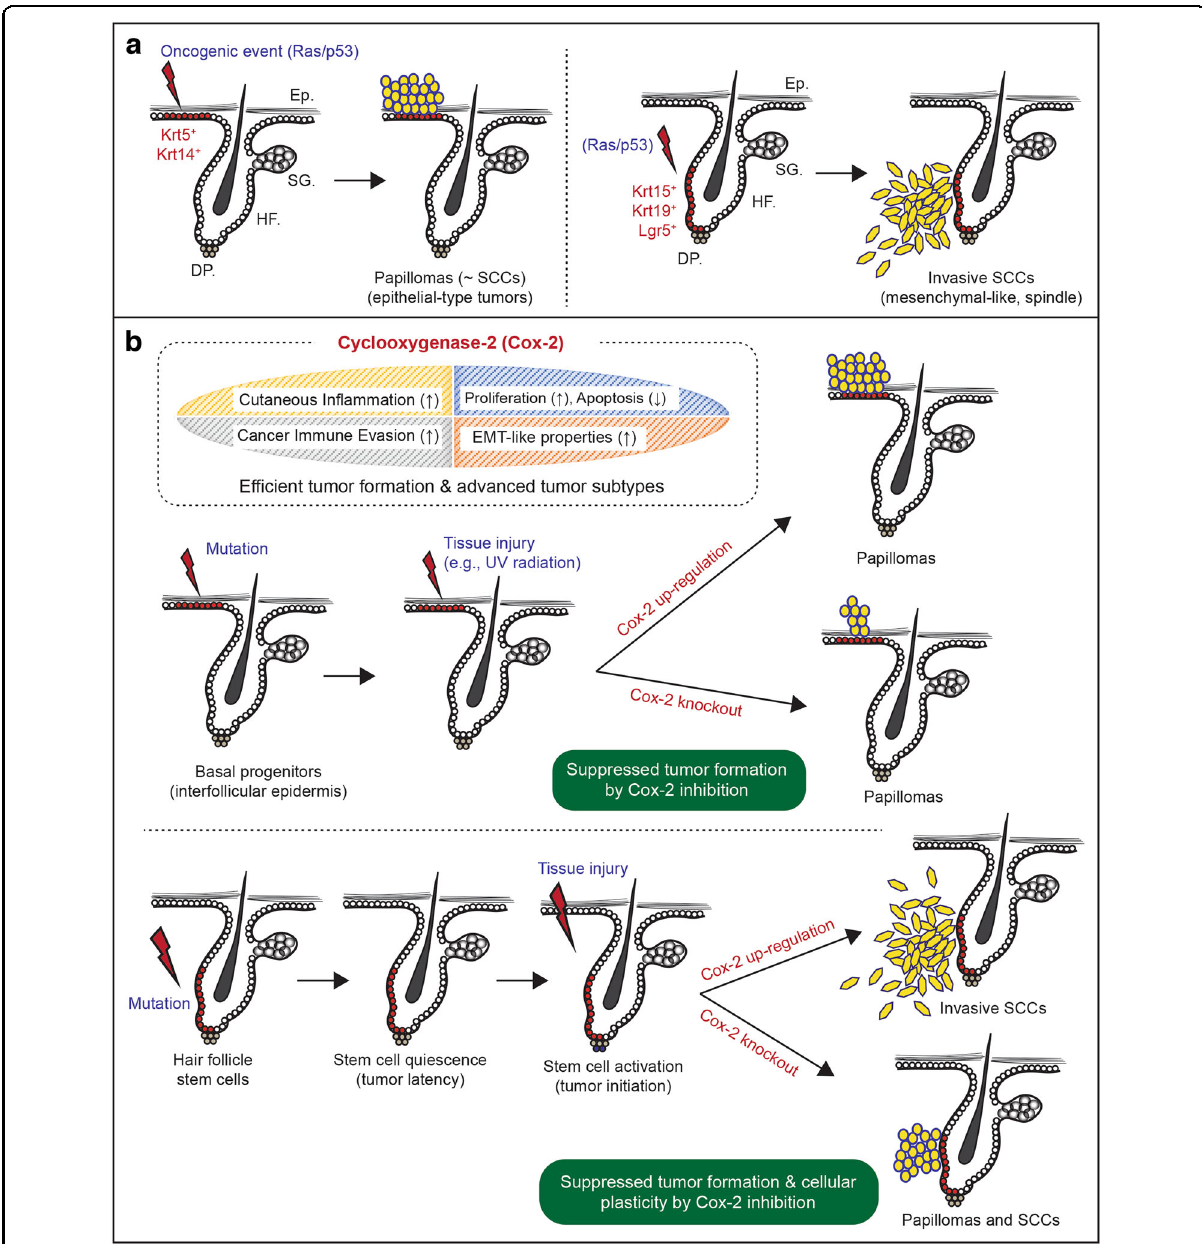
Fig. 1 The role of Cox-2 in stem/progenitor cells during the earliest stages of cutaneous SCCs. a Oncogenic expression of Ras (gain-of- function) and p53 (loss-of-function) can induce papillomatous tumors from basal stem/progenitors at the interfollicular epidermis. The same oncogenic combination ( Ras/p53 ) in hair follicle stem cells can directly induce a more invasive form of SCC, mesenchymal-like spindle cell carcinoma. Ep., epithelium; SG., sebaceous gland; HF., hair follicle; DP., dermal papilla. b Skin damage, for example, UV exposure-induced skin damage, can accelerate tumorigenesis via Cox-2 upregulation from tumor-prone stem/progenitor cells. However, cell-type-speci fi c knockout of Cox-2 can suppress tumor formation from both epidermal basal stem/progenitors and hair follicle stem cells. Furthermore, Cox-2 inhibition can suppress the cellular plasticity of hair follicle stem cell-originating cutaneous SCCs and lead to the formation of less aggressive SCC